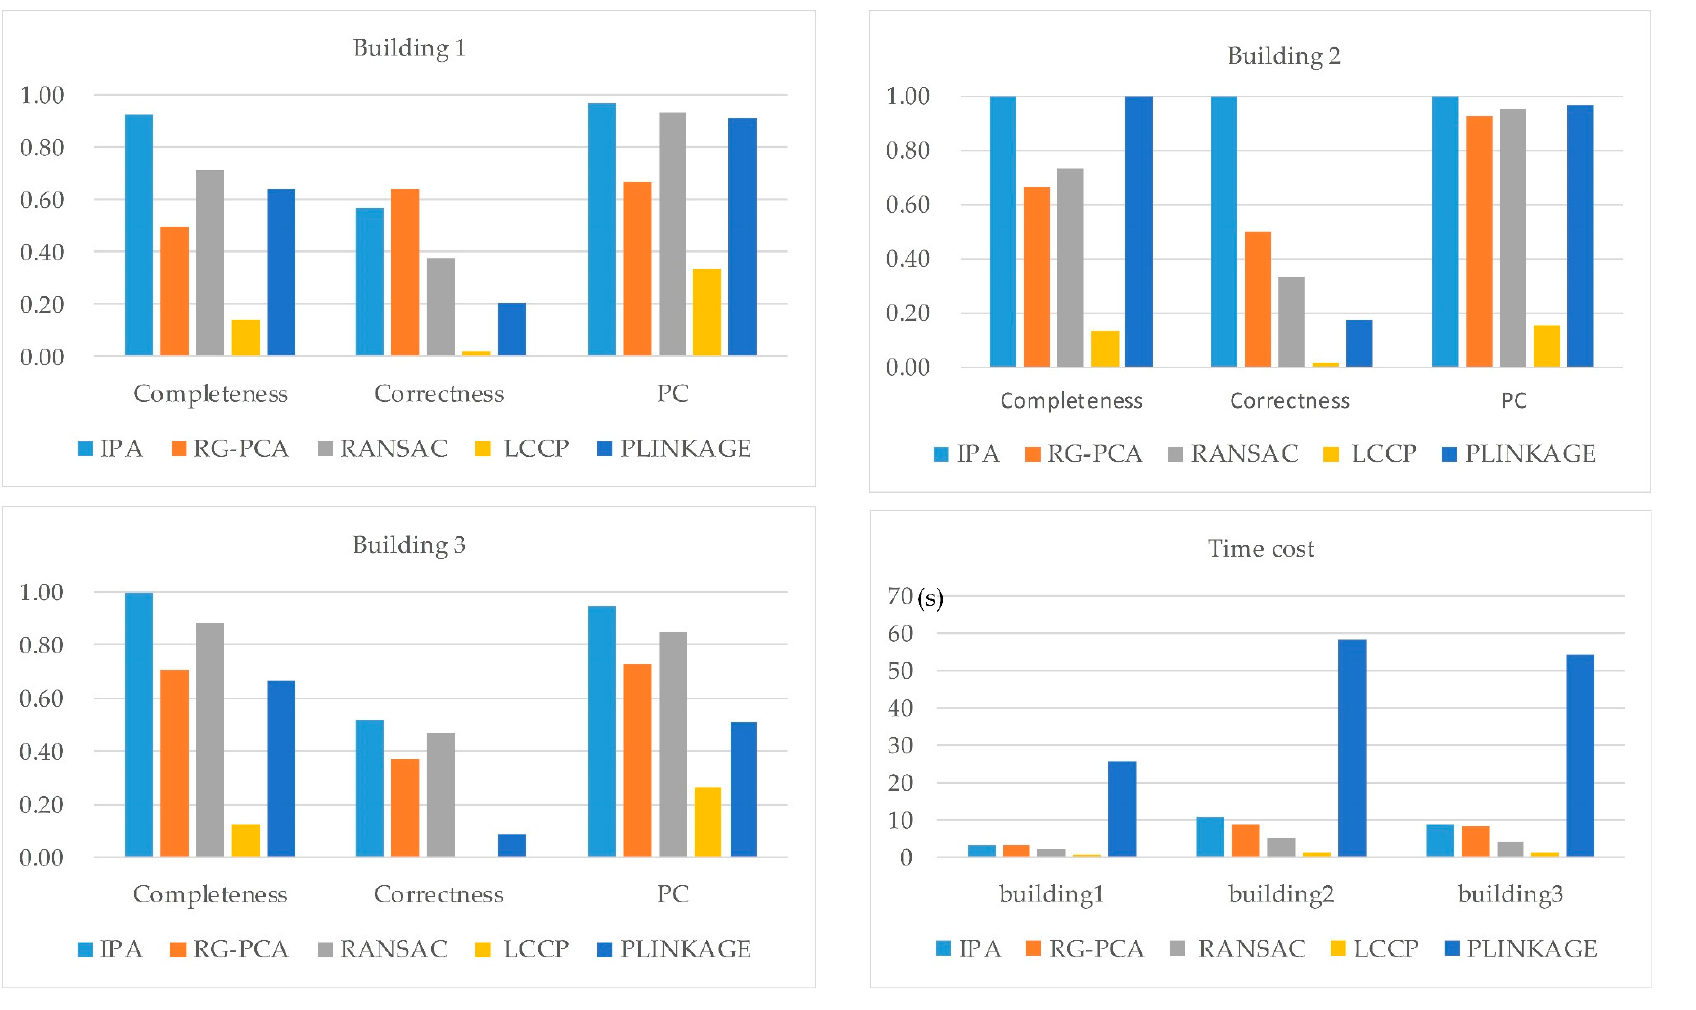
Figure 14. Efficiency analysis of algorithms.